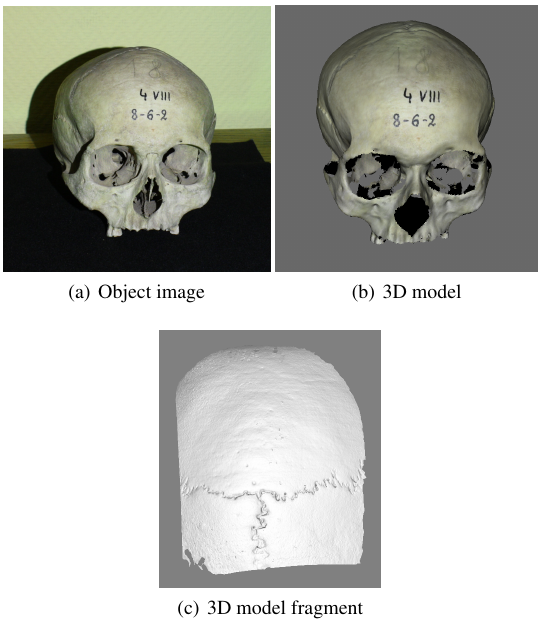
Figure 3. An object and its textured 3D model